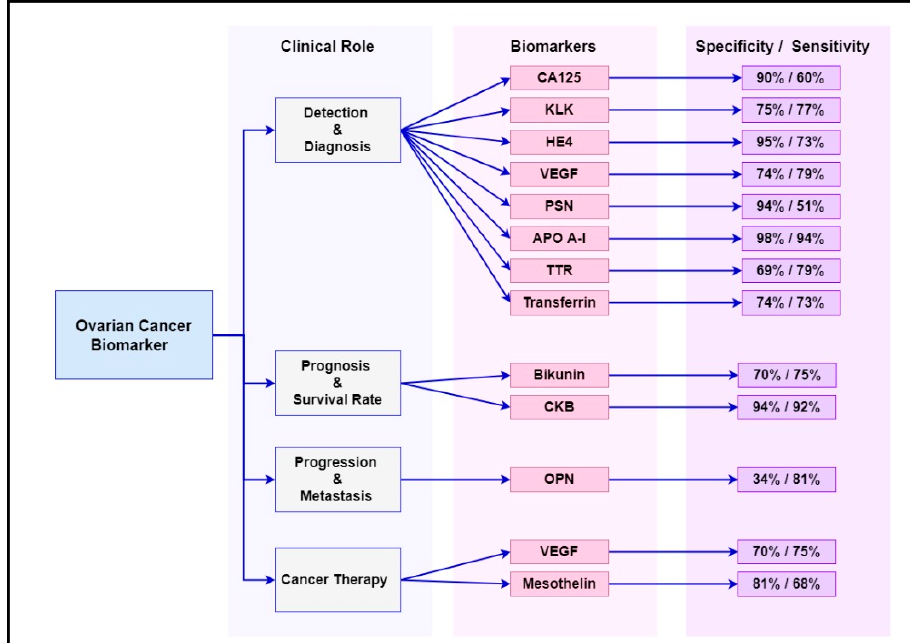
Figure 1. Summary of the sensitivity and specificity of the most common ovarian cancer biomarkers at early stages (stage I–II) of the disease.